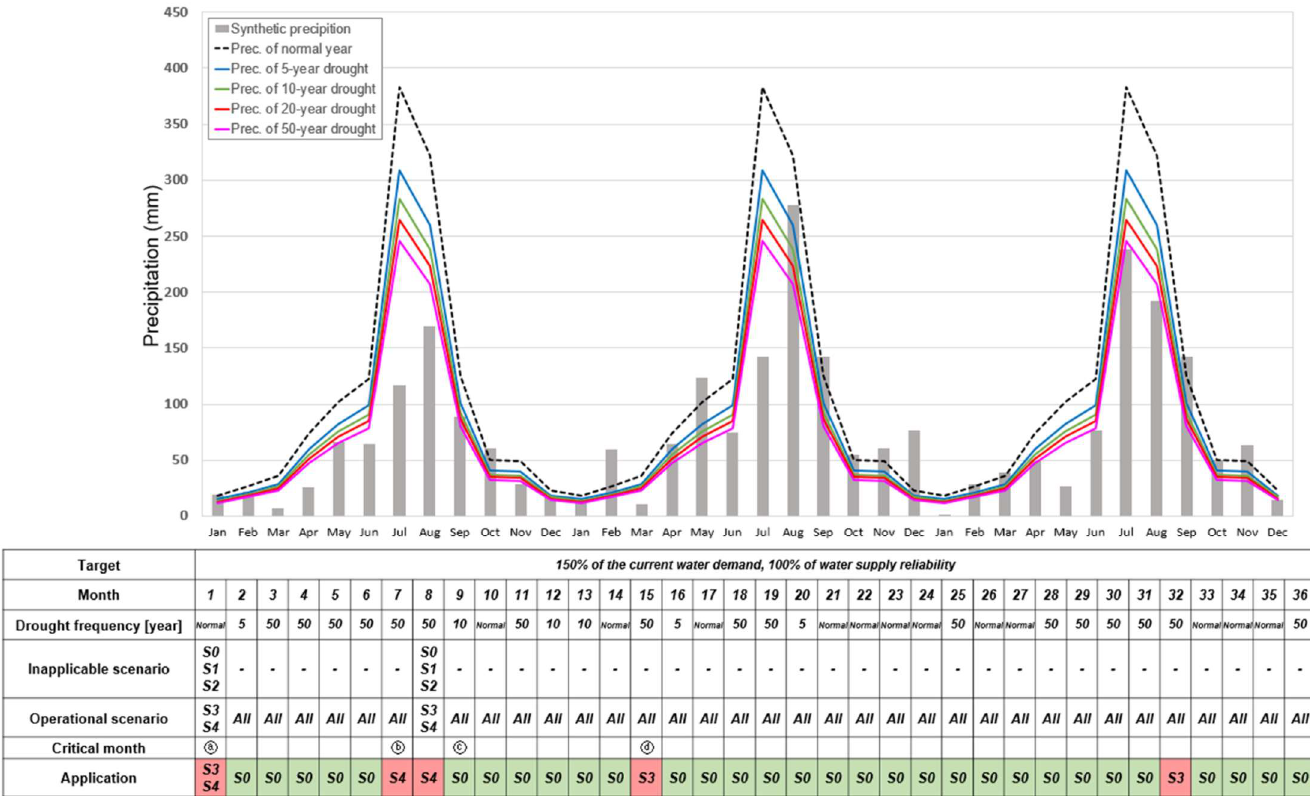
Figure 9. Illustrative operation with conjunctive use scenarios.